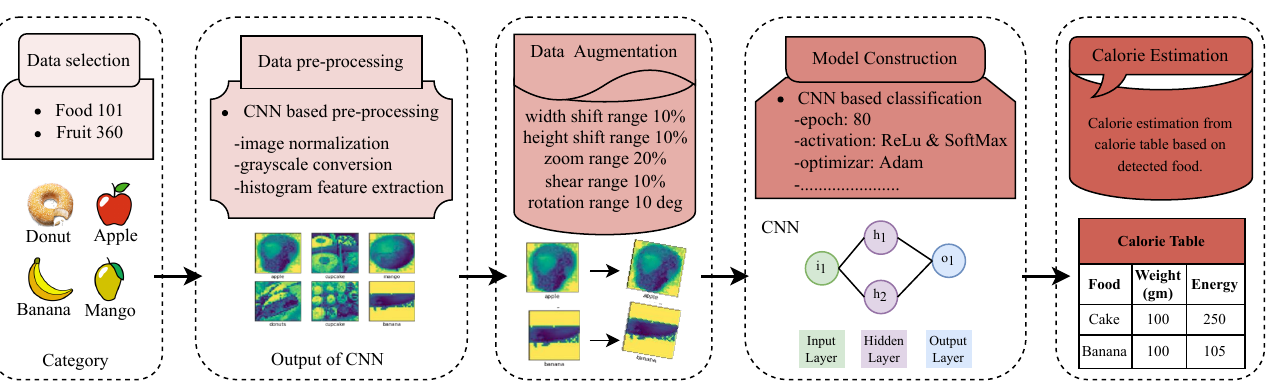
Figure 1. System model for image-based food calorie